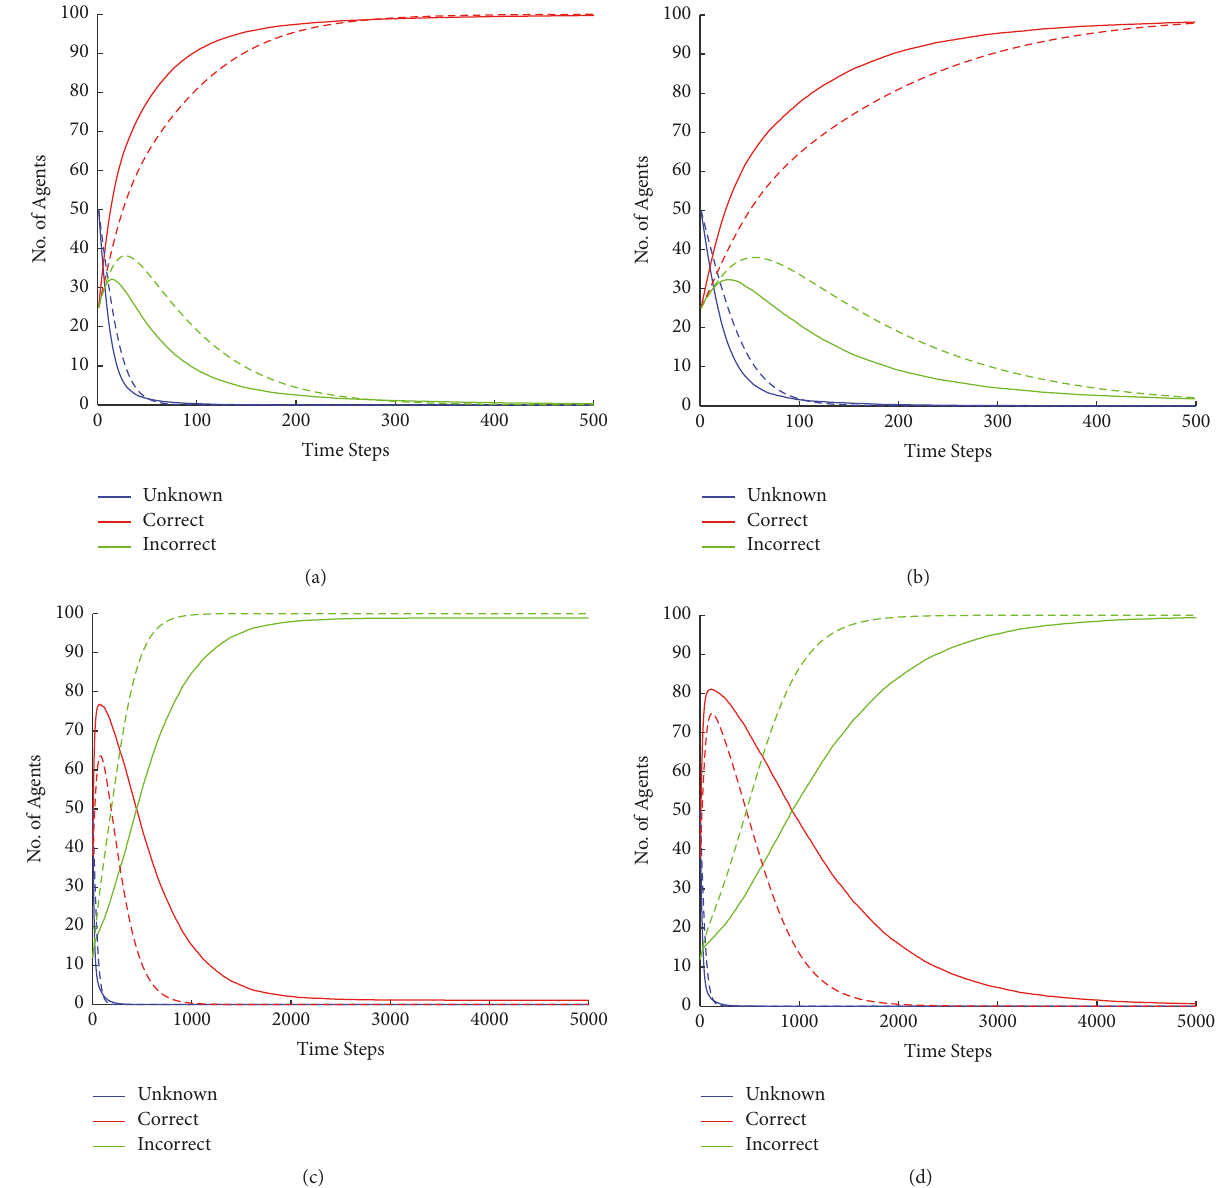
Figure 11: Results against both scenarios against reduced transition rates. (a) MLM case against “nominal scenario” with original transition rates; (b) MLM case against “nominal scenario” with reduced transition rates; (c) MLM case against “wishful-thinking scenario”; (d) MLM case against “wishful-thinking scenario” with reduced transition